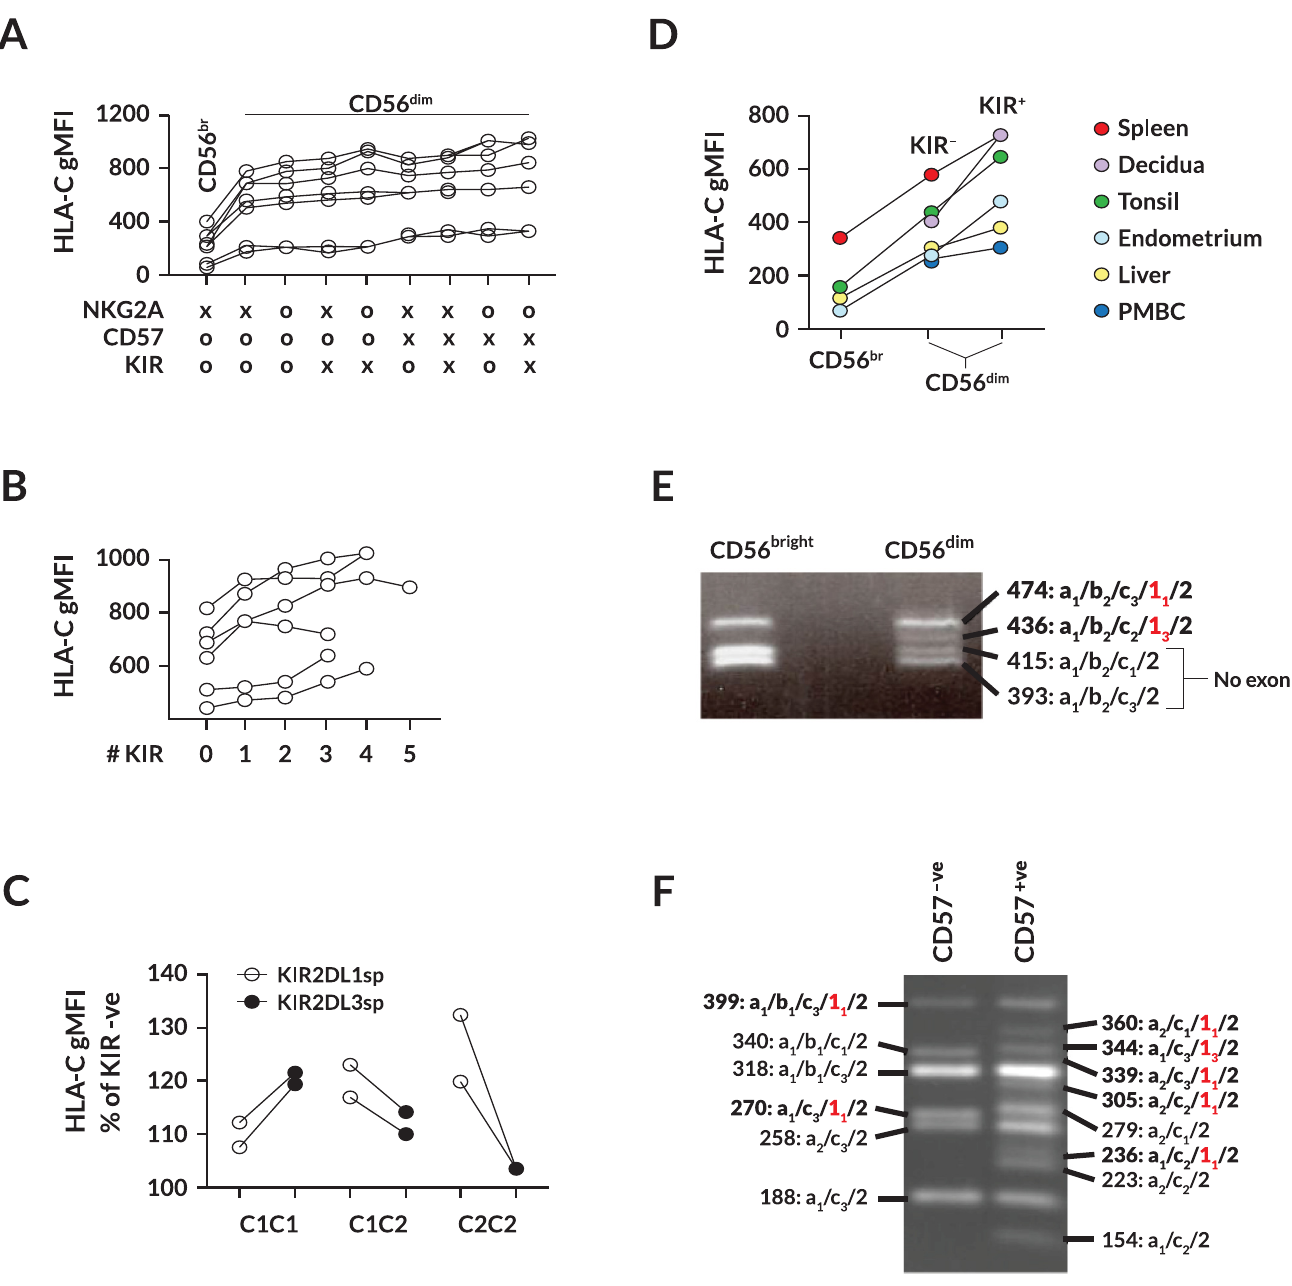
Fig 5. HLA-C expression levels increase and exon 1 skipping decreases as NK cells mature. (A) HLA-C geometric mean fluorescence intensity (gMFI) on NK cell subsets from seven PBMC donors. The presence (X) or absence (0) of NKG2A, CD57, or KIR (any combination of KIR2DL1/2/3/S1/S2/S4 or KIR3DL1) is indicated. The CD56 bright (CD56 br ) population is represented by a single phenotype, whereas CD56 dim NK cells contain eight distinct subsets. (B) HLA-C gMFI on CD56 dim NK cell subsets with differing numbers of co-expressed KIRs. PBMC from six donors were tested for the expression of the KIR2DL1/2/3/S1/S2/S4 or KIR3DL1 proteins on NK cell subsets. The number of co-expressed KIR (0–5) detected is plotted against the observed HLA-C level for each donor. (C) Comparison of HLA-C gMFI on NK cells expressing KIR2DL1 alone (KIR2DL1sp, negative for NKG2A, CD57 and other KIRs, open circles), versus KIR2DL3 single-positive NK cells (KIR2DL3sp, negative for NKG2A, CD57 and other KIRs, filled circles) in donors that possess only KIR2DL1 ligands (C2C2), KIR2DL3 ligands (C1C1) or both (C1C2). HLA-C expression is shown as a percentage relative to KIR-negative NK cells. Two donors of each HLA-C haplotype were tested. (D) Summary of HLA-C gMFI on CD56 bright versus CD56 dim /KIR-negative (KIR-) and CD56 dim /KIR-positive (KIR+) NK cells from various tissues. Decidual NK cells are shown as two points under KIR- and KIR+, since all cells in the decidua are CD56 bright . (E) PCR using NK-Pro primers (5´exon -1a/3´exon 2) on cDNA from sorted CD56 bright versus CD56 dim NK cells from a donor homozygous for the HLA-C (cid:3) 06 allele. The size and exon content of each band is indicated on the right. Transcripts containing exon 1 are in bold, and red type indicates exon 1. (F) PCR of cDNA from sorted CD56dim/CD57-negative (CD57-ve) versus CD56 dim /CD57-positive (CD57+ve) NK cells using the primers in (C), but from a donor containing the HLA-C (cid:3) 15 / (cid:3) 16 alleles. The exon content of bands found in the CD57-negative subset are indicated on the left, and additional bands found in the CD57-positive cells are shown on the right. https://doi.org/10.1371/journal.pgen.1007163.g005 PLOS Genetics | https://doi.org/10.1371/journal.pgen.1007163 January12, 2018 9 /